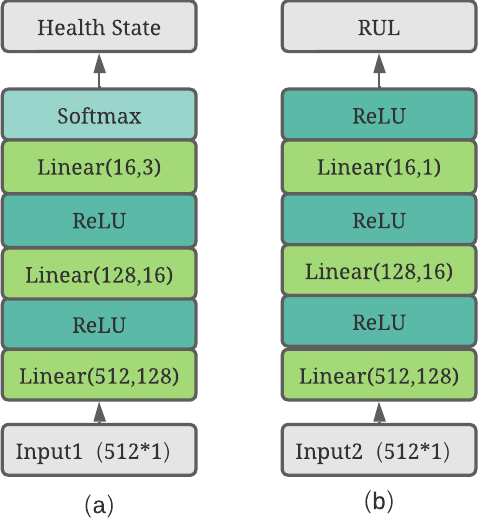
Figure 7. Details of two tower networks. ( a ) health state tower; ( b ) RUL